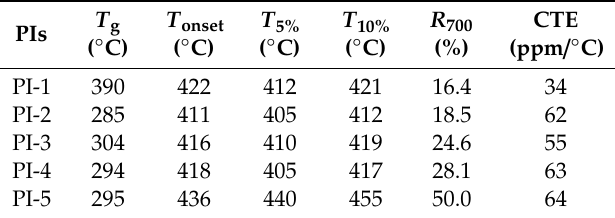
Table 3. Thermal properties of semi-alicyclic polyimide films a